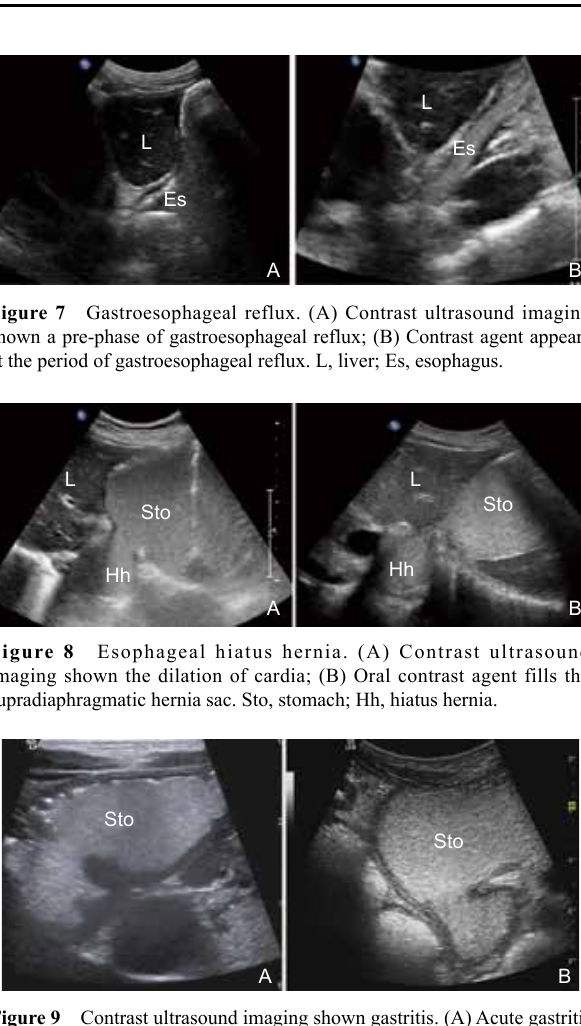
Figure 9 Contrast ultrasound imaging shown gastritis. (A) Acute gastritis (lesser curvature of gastric body); (B) Chronic gastritis (gastric angle). Sto, stomach.